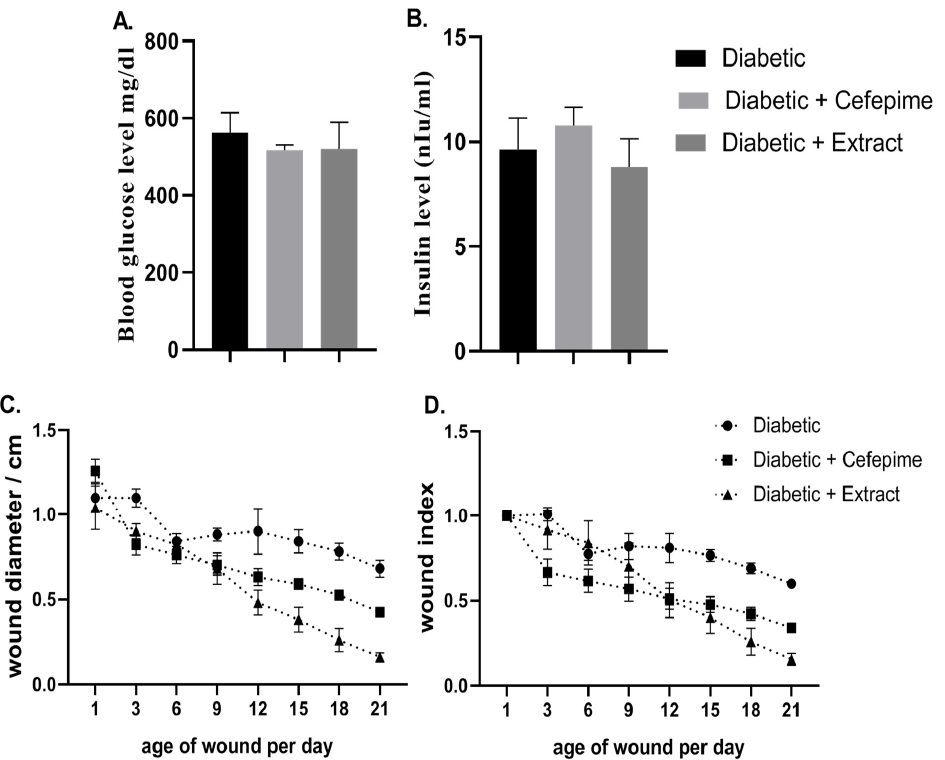
Figure 2. Glycemic ( A , B ) and wound parameters of Type 1 diabetic rats throughout 21 days. Fasting blood glucose level (mg/dL) ( A ), serum insulin level (mIU/I) ( B ), wound diameter (cm) ( C ) and wound index ( D ).